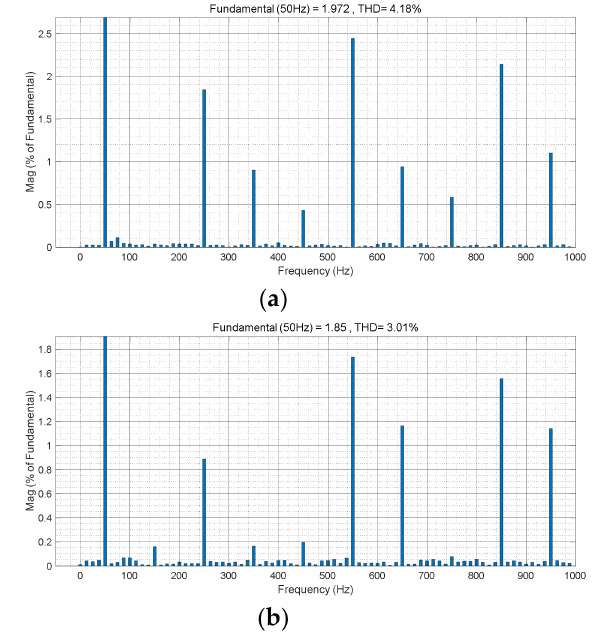
Figure 17. Phase A current distortion rate under an unbalanced load with different harmonic damping control coefficients. ( a ) The distortion rate of the phase A current ( K = 500). ( a ) The distortion rate of the phase A current ( K =